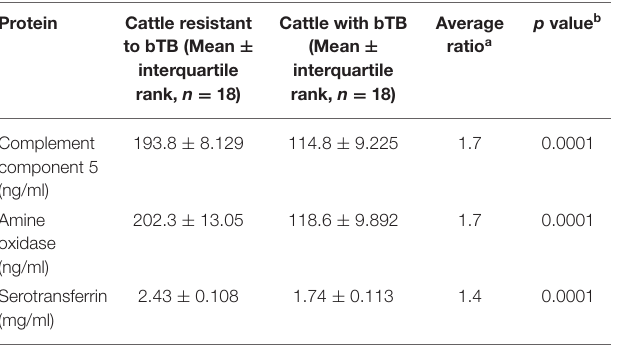
TABLE 3 | Concentration values of candidate biomarkers in serum samples of bTB-resistant cattle and bTB-susceptible cattle determined by in-house ELISAs. Protein Cattle resistant Cattle with bTB to bTB (Mean ± (Mean ± interquartile rank, n = 18)